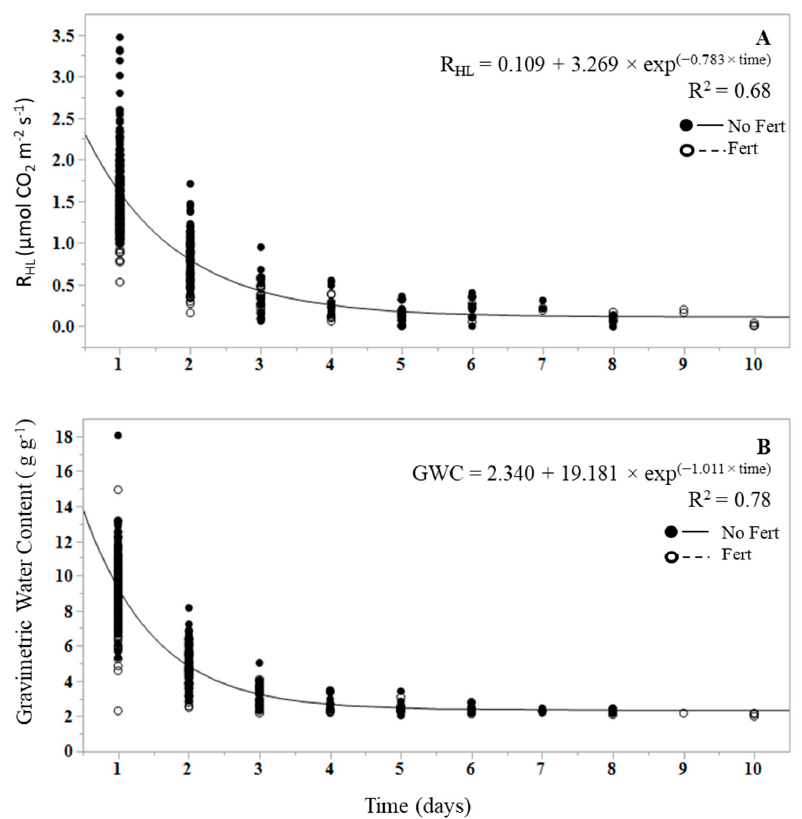
Figure 2. Change in ( A ) litter heterotrophic respiration (R HL ) and litter water content ( B ) following the initial wetting event over the duration of the dry down (days) in unfertilized (closed symbols) and fertilized samples (open symbols). The line represents the fit of the exponential decay function. Data represent actual values for each replicated treatment.